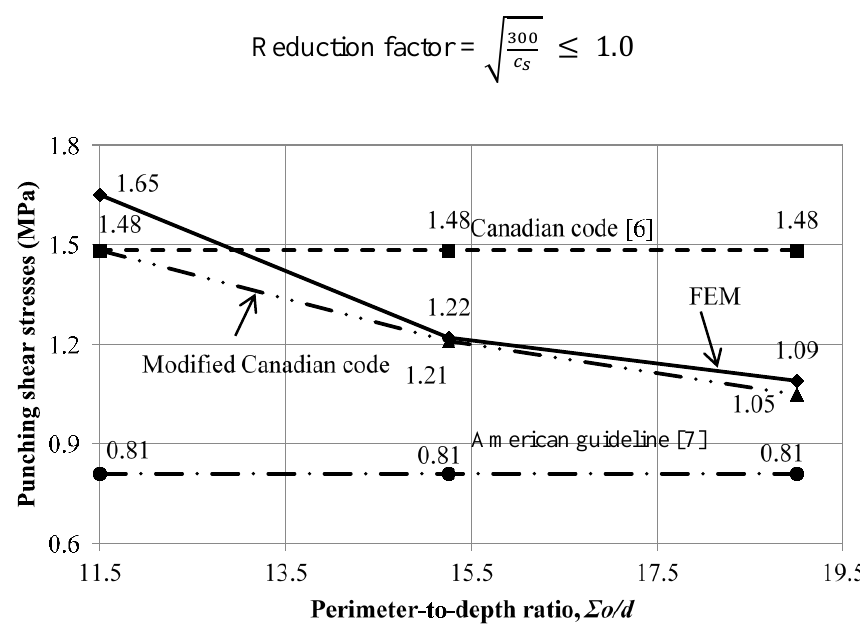
Figure 14. Relationship between the punching shear stress at failure and the perimeter-to-depth